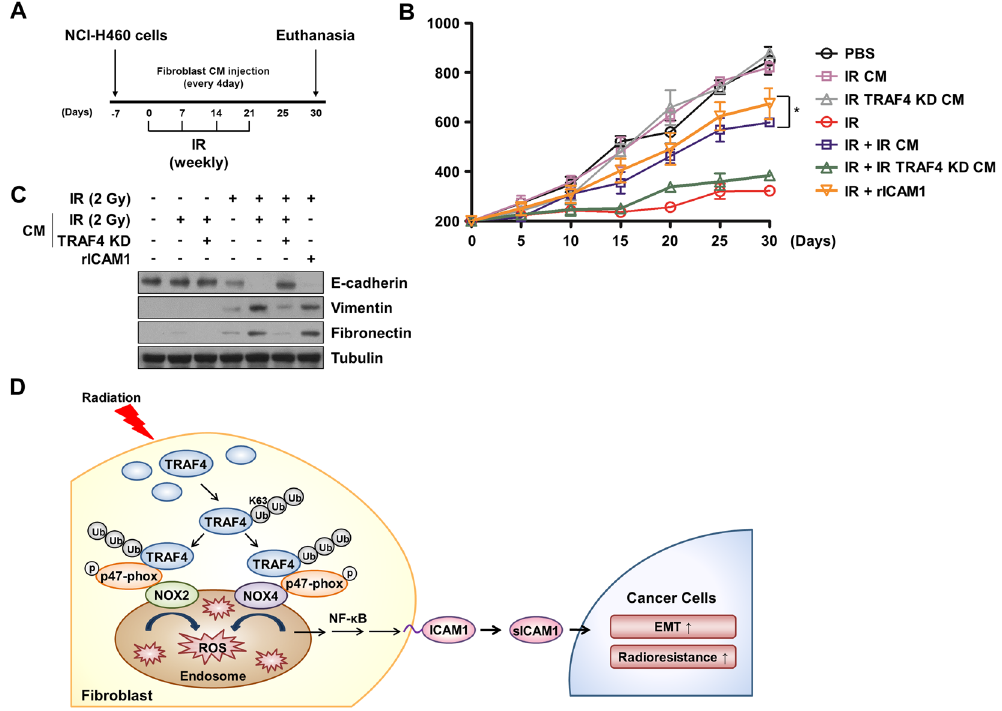
Figure 6. CM from TRAF4-knockdown fibroblasts suppressed in vivo tumor progression of NSCLC in a mouse xenograft model. ( A ) Schematic description for generation of mouse xenograft model and treatment of CM. Radiation exposure was locally treated to xenografted tumor sites and each CM was treated for every 4 d, or rICAM1 three times weekly. ( B ) Effects of CM on tumor growth were measured in a mouse xenograft model. Error bars, ± SEM (n = 3); * p < 0.05 compared with irradiated tumor volume. ( C ) In vivo effects of CM on EMT marker of tumor were assessed by Western blotting. ( D ) A schematic diagram illustrates how radiation- induced TRAF4 in fibroblasts promotes lung cancer progression. TRAF4 stabilizes NOX complex and increases secretion of sICAM1 which induces EMT and radioresistance of lung cancer